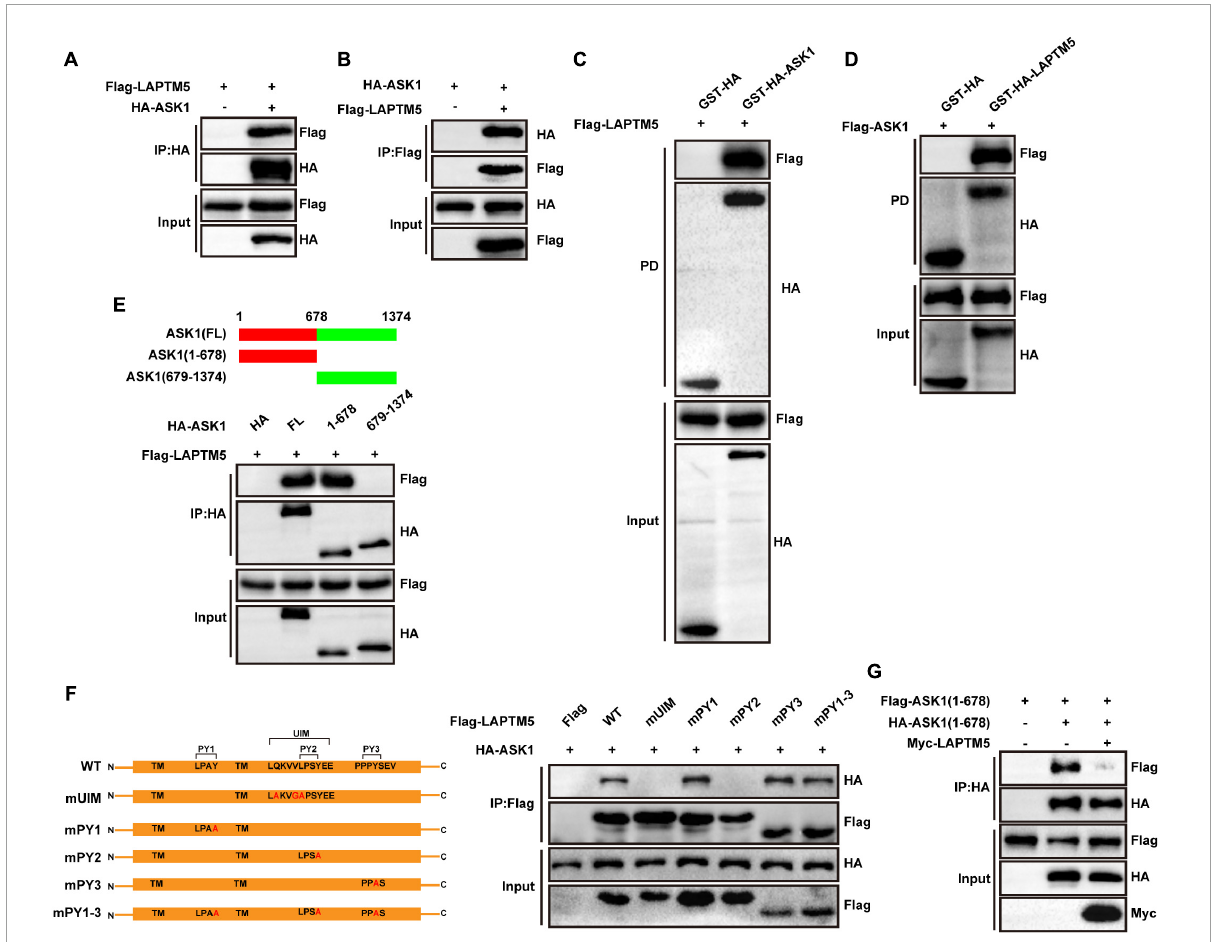
FIGURE8 LAPTM5 inhibits ASK1 N-terminal dimerization by directly interacting with ASK1. (A,B) Co-IP assays were performed to show the interaction between LAPTM5 and ASK1 in 293T cells transfected with the indicated plasmids. (C,D) GST pull-down assays showed the direct interaction of LAPTM5 and ASK1 in 293T cells transfected with the indicated plasmids. (E) Top, schematic of full-length or truncated ASK1; bottom, Co-IP assay results revealed that the N-terminus of ASK1 [ASK1(1-678 aa)] was responsible for its interaction with LAPTM5. (F) Left, schematic of full-length or mutant LAPTM5; right, Co-IP assays results revealed that the UIM and PY2 motifs of LAPTM5 were responsible for its interaction with ASK1. (G) Co-IP assays demonstrated that LAPTM5 inhibits ASK1 N-terminal dimerization in 293T cells transfected with the indicated plasmids. For (A–G) , the results are representative of three independent